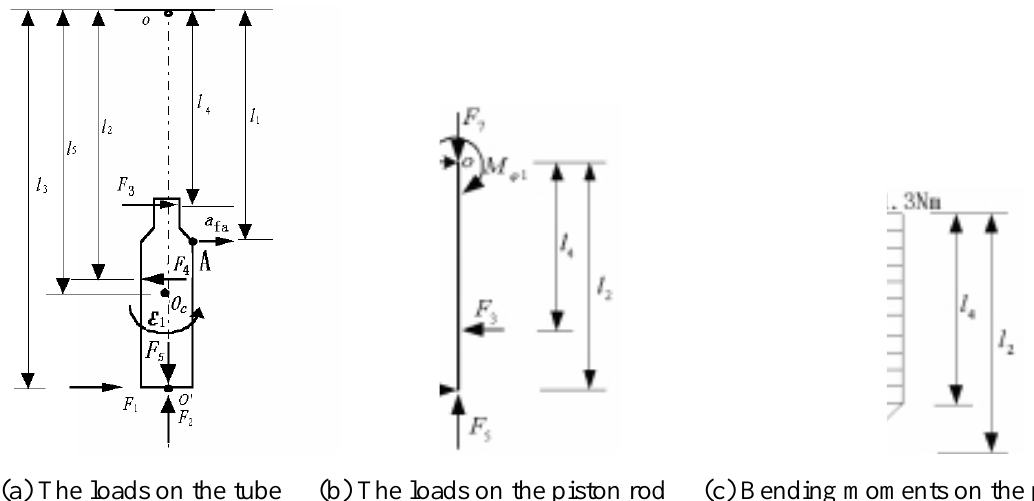
Fig. 9. (a) The loads on the tube (b) The loads on the piston rod (c) Bending moments on the piston rod External and internal forces acting on the absorber in the wheel plane. Table 1 Geometrical and physical parameters of the absorber Parameters